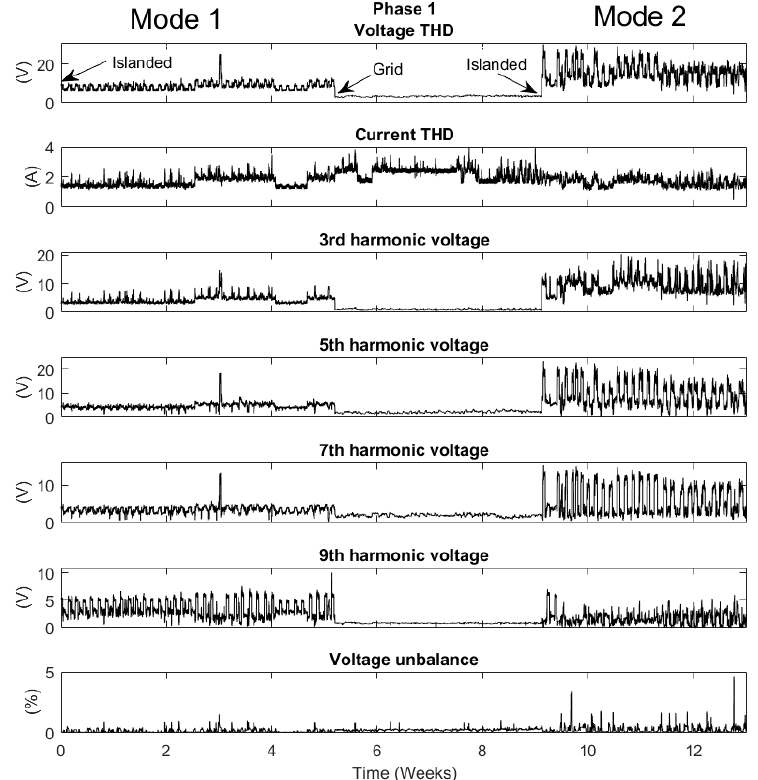
Figure 13. Short circuit impedance for 13 weeks of islanded and grid-connected measurements. The number of samples are around 31,000, 730 and 11,000 for phase 1 to 3 respectively. Note the difference in horizontal scale for each sub-plot.